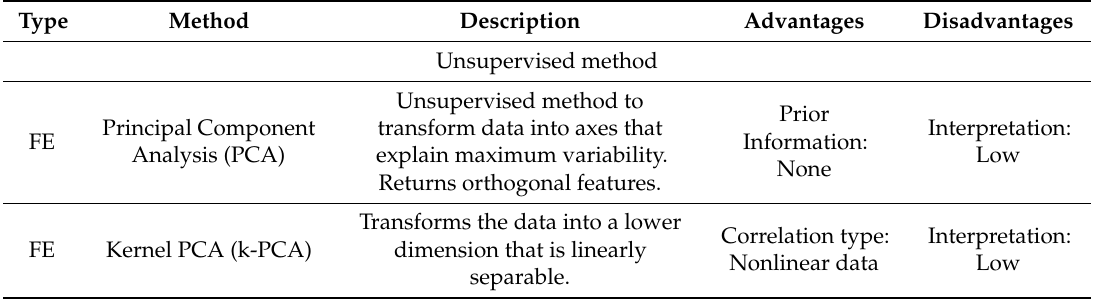
Table 5. Dimensionality reduction strategies. FS—feature selection; FE—feature